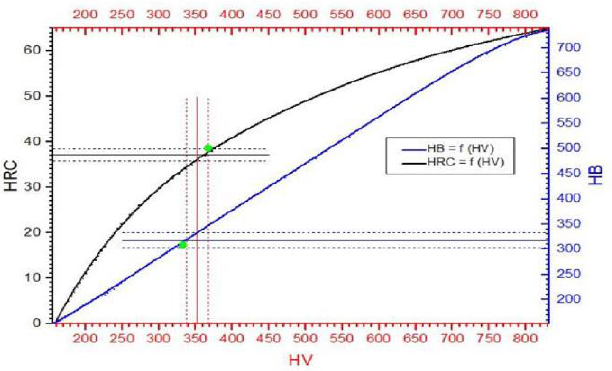
Figure 17. Comparison of the hardness measurements obtained with the Rockwell PW 106 hardness tester and the Wolpert Wilson Testor 751 universal hardness tester.